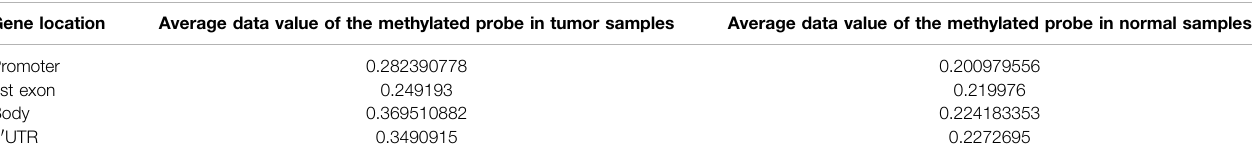
TABLE 2 | Average data value of the SHOX2 methylated probe between LUAD and normal samples. Gene location Average data value of the methylated probe in tumor